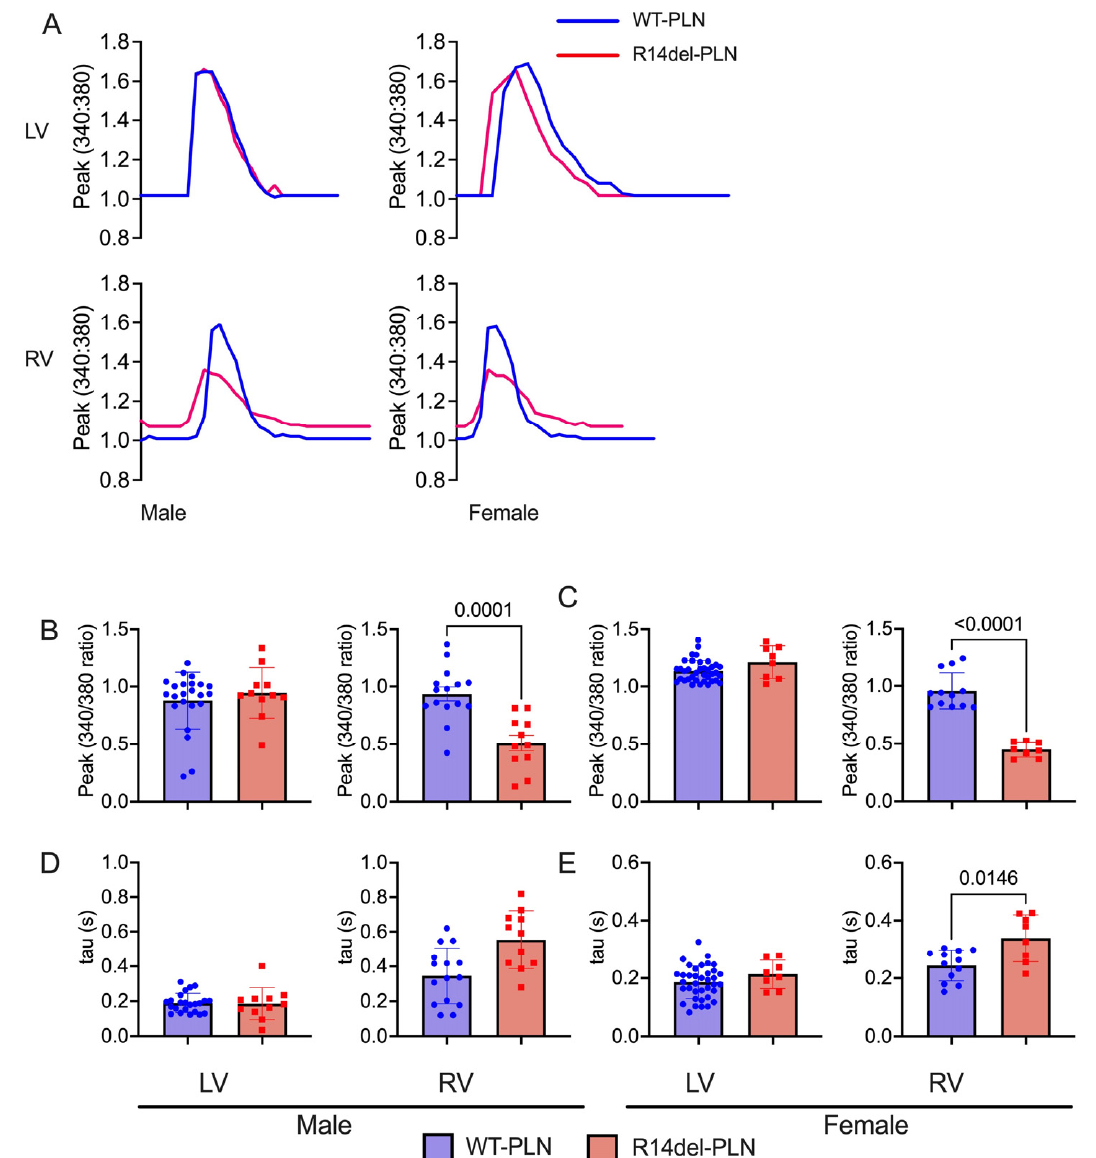
Figure 5. Ca 2+ kinetics in isolated cardiomyocytes from 12-month-old male and female WT- PLN and R14del- PLN mice. ( A ) Shown are representative Ca 2+ transient tracings of WT- PLN and R14del- PLN . ( B , C ) Ca 2+ transient amplitude, as indicated by the Fura-2 ratio (340:380 nm) at 0.5 Hz with 1.8 mM Ca. ( D , E ) Relaxation time constant (tau) of calcium transient decay. n = 23 LV and 15 RV cells for WT- PLN males (N = 3 hearts); n = 37 LV and 12 RV cells for WT- PLN females (N = 5 hearts). n = 13 LV and 11 RV cells for R14del- PLN males (N = 3 hearts); n = 8 LV and 8 RV cells for R14del- PLN females (N = 3 hearts). Data are expressed as mean ± SD for the number of cells, and statistical analyses were performed with Student’s unpaired t -test.